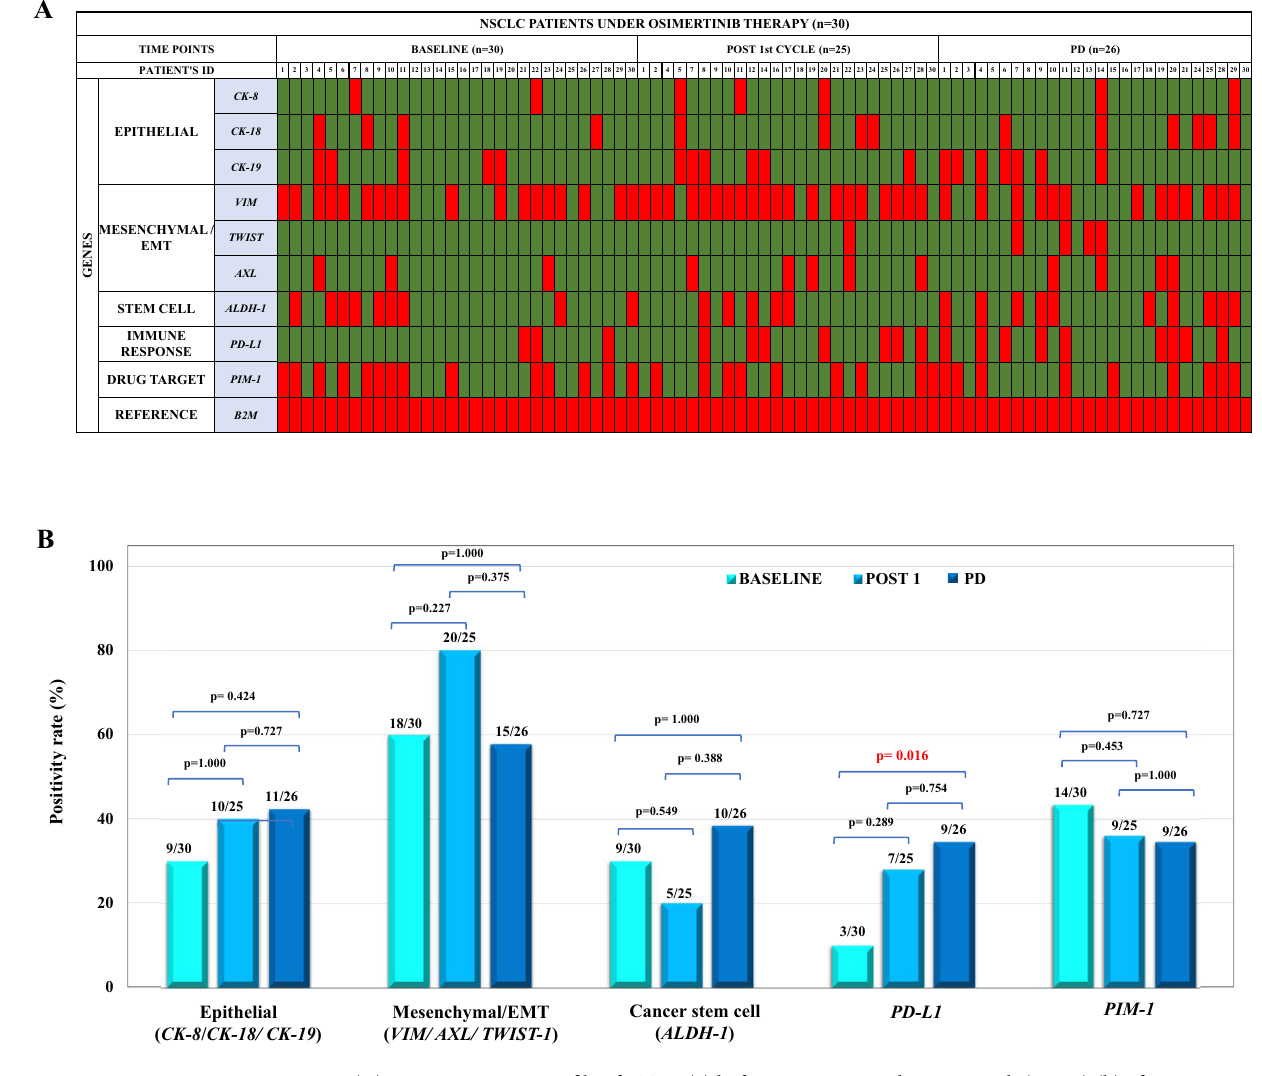
Figure 3. ( A ) Gene expression profile of CTCs: (a) before treatment with osimertinib (n = 30) (b) after one cycle of treatment (n = 25) and (c) at progression of disease (PD) (n = 26) (red: overexpressed, green: no expression). SD: stable disease, PR: partial response, CR: complete response, PD: progression of disease. ( B ) Positivity rates of gene expression in CTCs at all time points. Expression of epithelial, mesenchymal/EMT, stem cell markers, PD-L1 and PIM-1 , at baseline, post-1st cycle, and